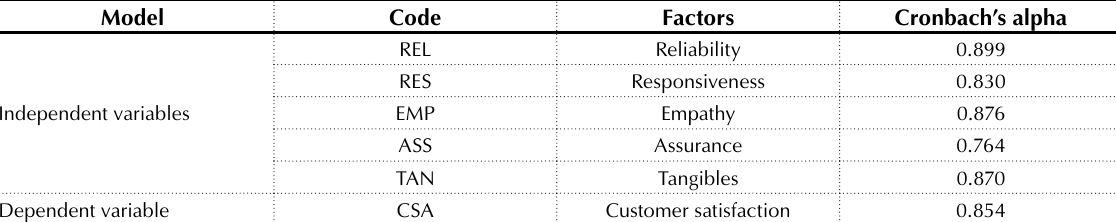
Source: The researcher’s collecting data.